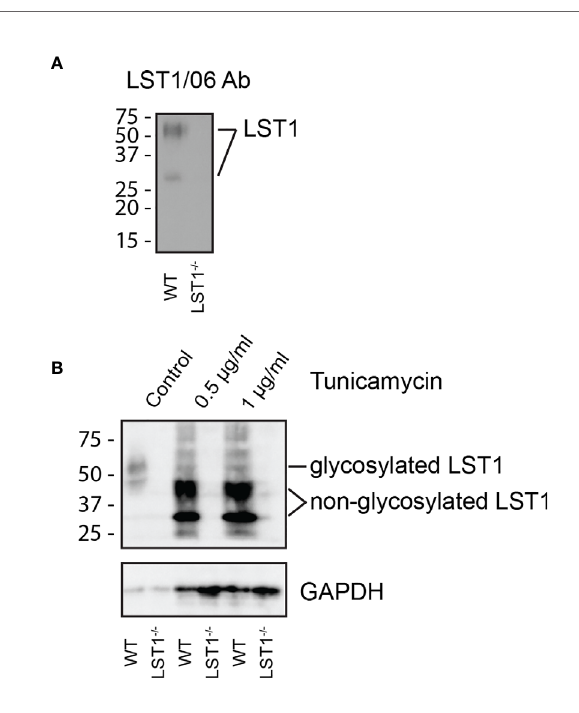
FIGURE 1 | Murine LST1 is a glycoprotein recognized by a newly developed antibody LST1/06. (A) Detection of murine LST1 by LST1/06 antibody in the LST1/06 immunoprecipitates from WT and Lst1 -/- BMDM in non-reduced samples (n=3). (B) Murine BMDM were cultured in the presence of tunicamycin (0.5 and 1 µg/ml). Cells were lysed and LST1 immunoprecipitated and analyzed by immunoblotting with LST1/06 antibody under non-reducing conditions (n=3). Note the electrophoretic mobility shift after tunicamycin treatment, which is indicative of LST1